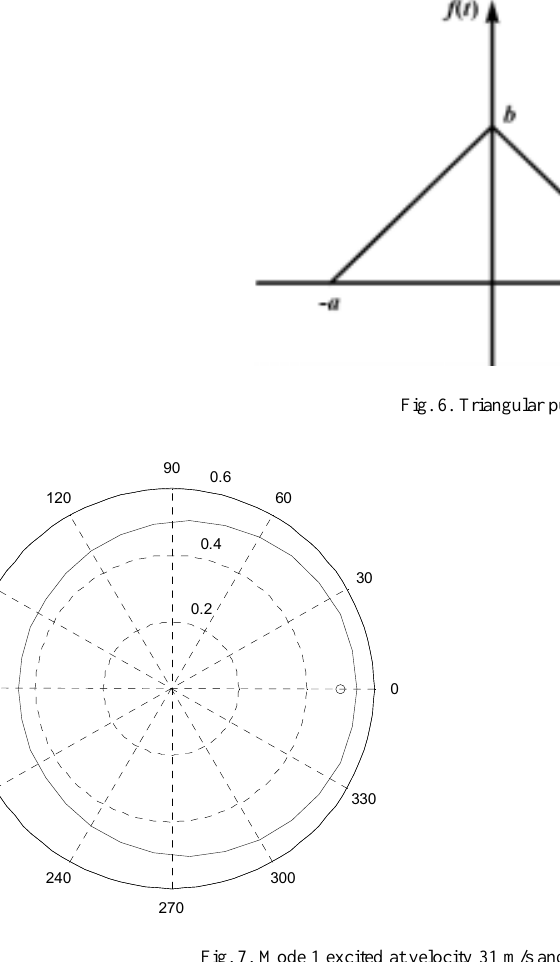
Fig. 7. Mode 1 excited at velocity 31 m/s and mode 2 at velocity 39.2